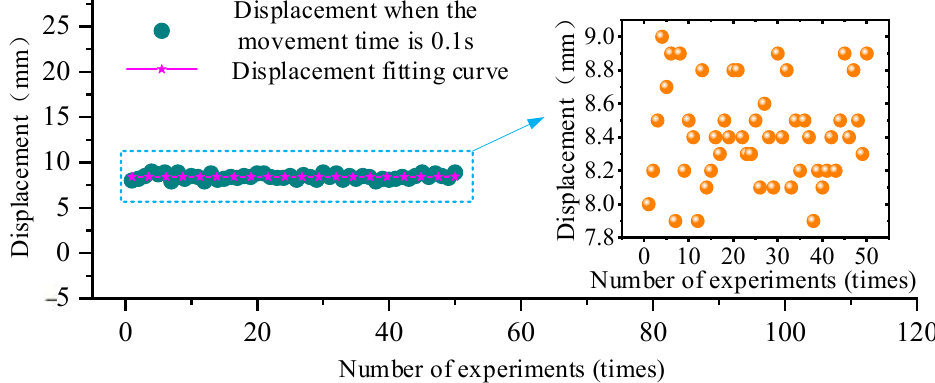
Figure 14. Variation curve of displacement with time during extension movement of the balance cylinder of hydraulic support.